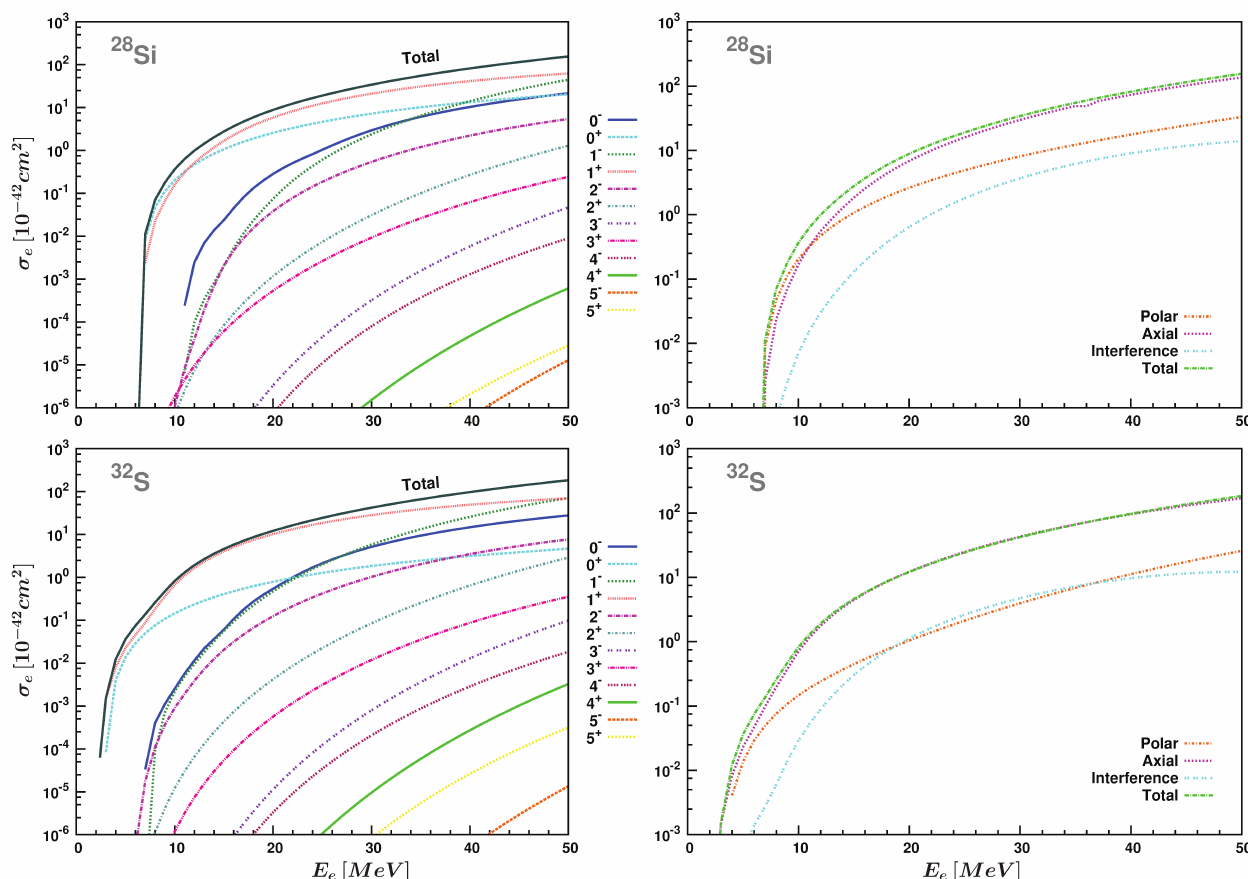
Figure 5. The individual contribution to the total e − -capture cross sections (bold, full line) of various channels ( J π ≤ 5 ± ) are demonstrated in this figure in 28 Si ( e − , ν e ) 28 Al and 32 S ( e − , ν e ) 32 P reactions. Moreover, in the right part of each figure, the individual contribution of the polar-vector, axial-vector and interference terms are also